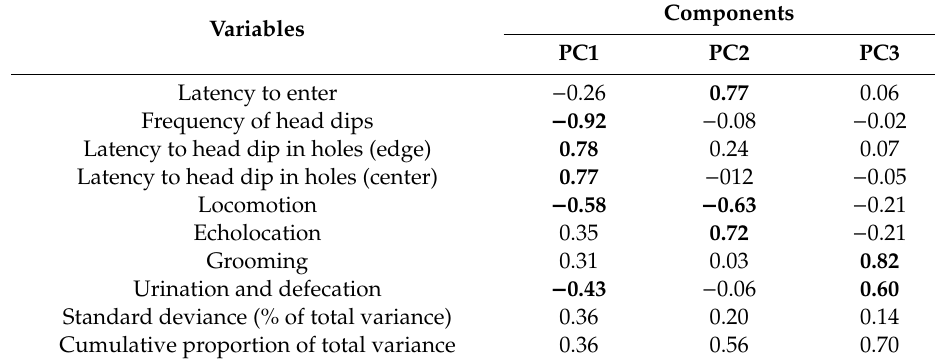
Table 1. Summary of principal component analysis of the hole-board test data for 52 female Asian particolored